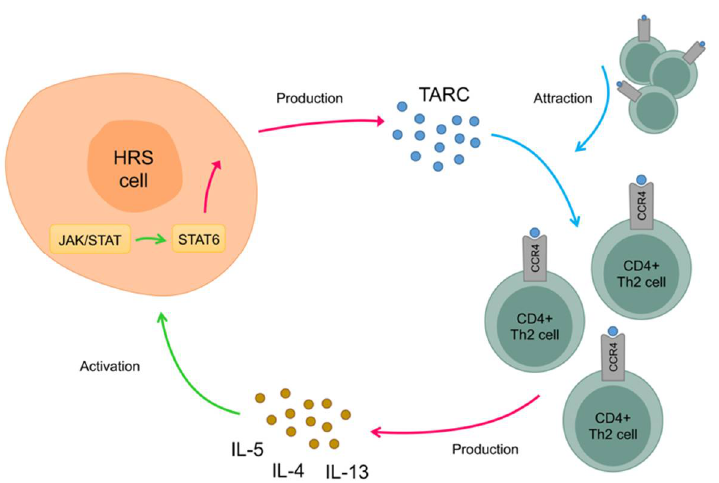
Figure 2. The interaction between Hodgkin and Reed–Sternberg (HRS) cells and CD4+ type 2 T helper (Th2) cells most likely initiates a positive feedback loop. First, the secretion of TARC (blue circles) by HRS cells causes a consequent attraction and homing of Th2 cells to the tumor microenvironment. These attracted Th2 cells can secrete IL-4, IL-5 and IL-13 (yellow circles) that activate JAK/STAT signaling leading to activation of STAT6. STAT6 activation in HRS cells further increases TARC secretion. This leads to a feedback loop of constant stimulation of HRS cells.